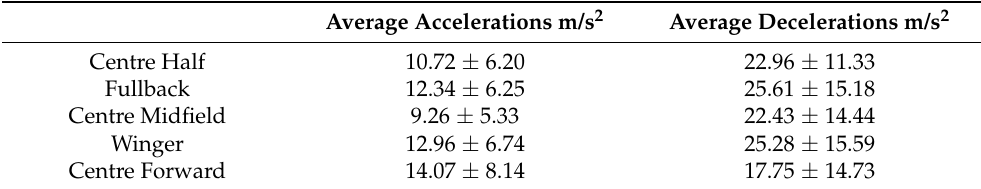
Table 3. Frequency of Positional Accelerations and Decelerations (Mean ± SD) within a 4–3–3 Formation over 45 Competitive League Two